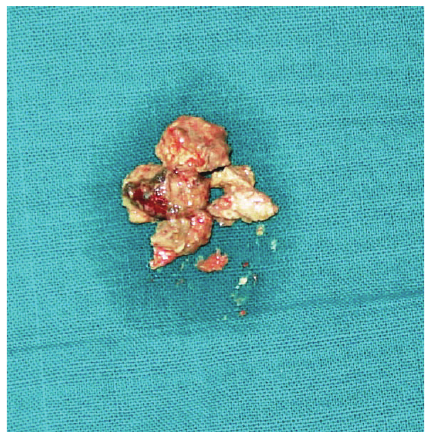
Figure 6: Postoperative